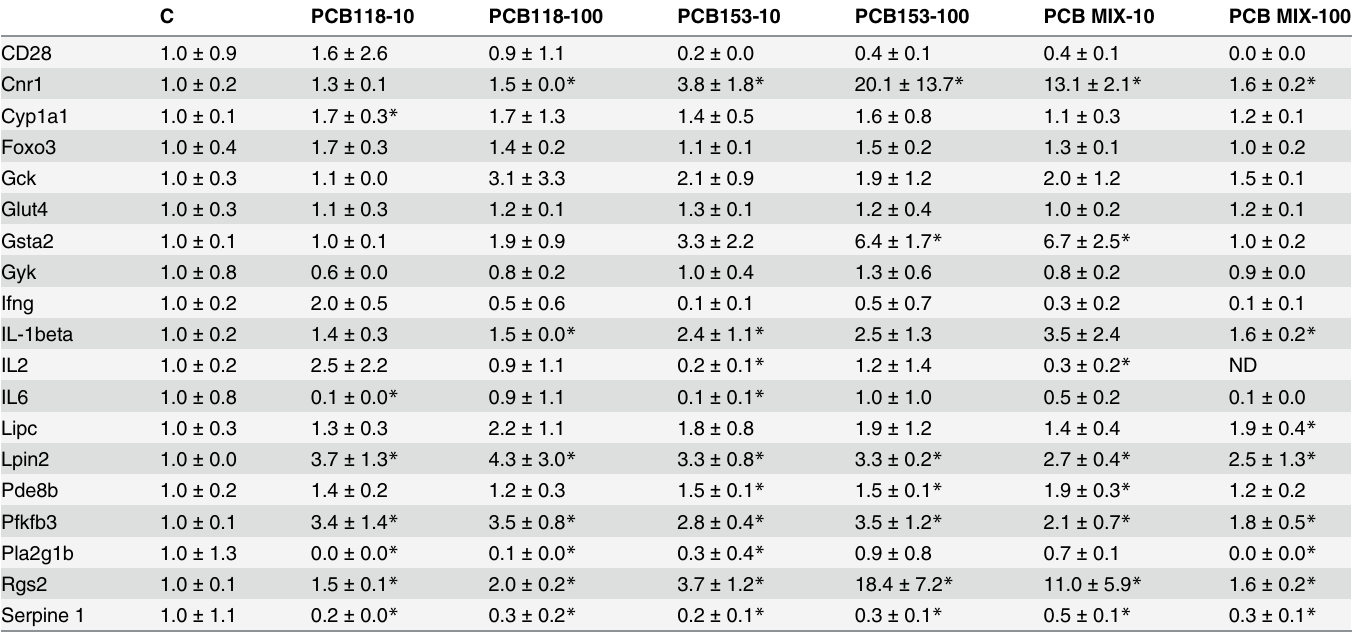
Table 10. Real-time RT-PCR validation of genes selected within the muscles after microarray analyses ( * p < 0.05). C